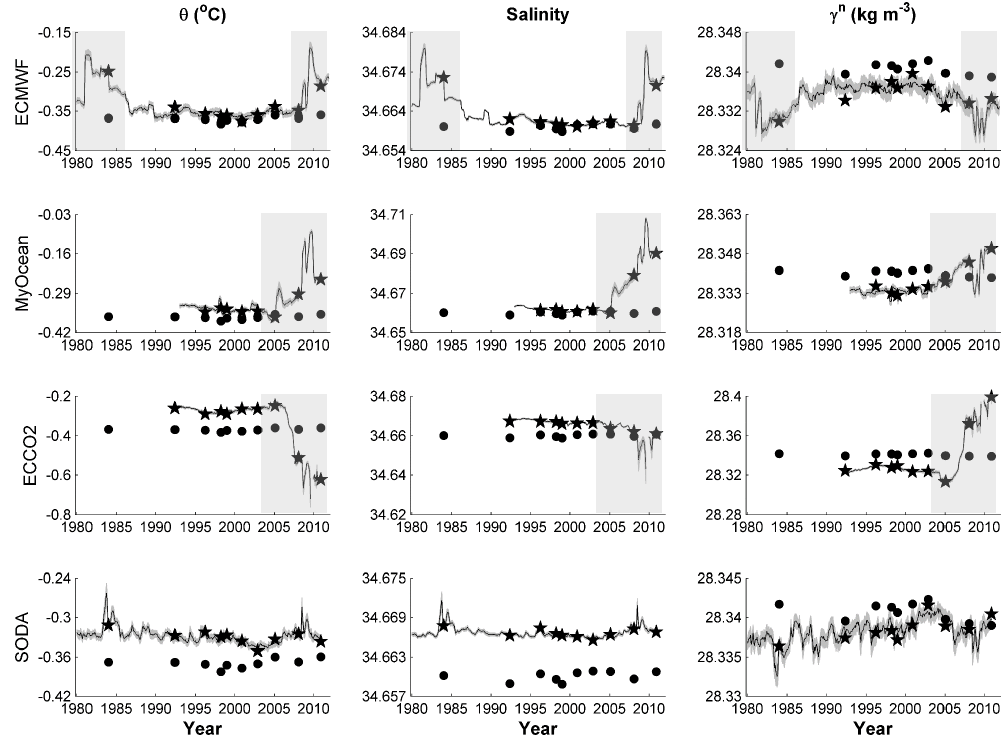
Figure 13. Same as in Fig. 11, but for WSDW. 1148